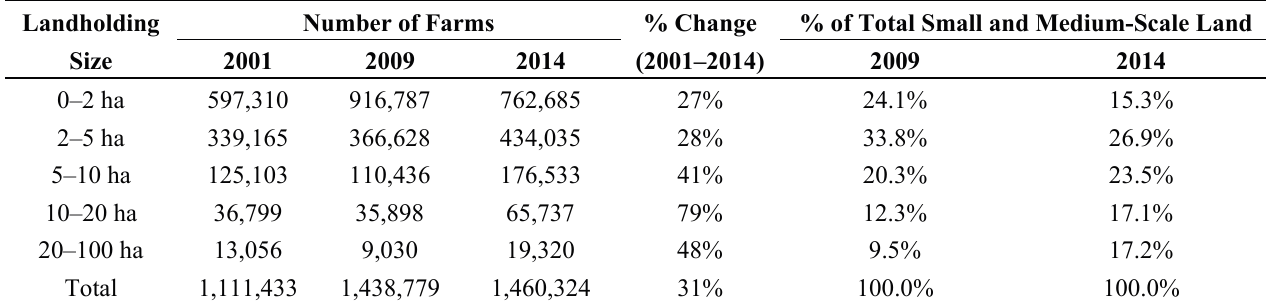
Table 2. Changes in farm structure among small- and medium-scale farmers in Zambia (2009–2012). Source: Ministry of Agriculture Supplemental Survey 2001 and Crop Forecast Surveys 2009 and